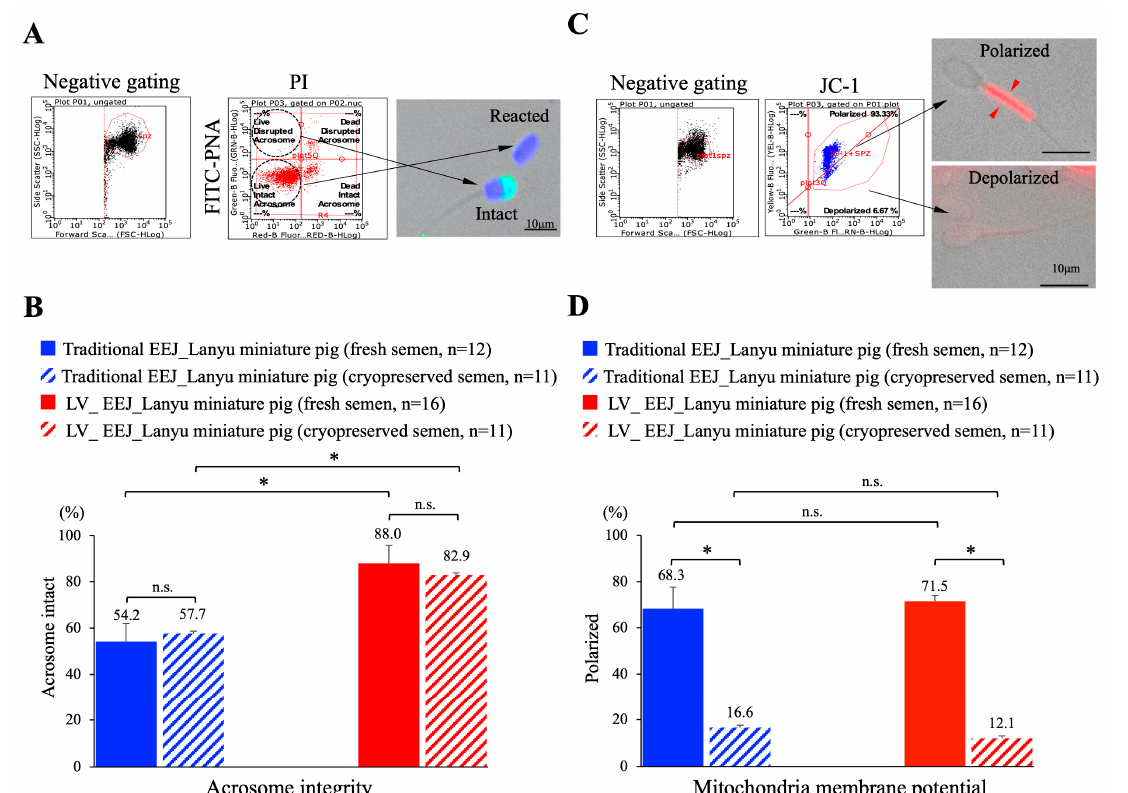
Figure 4. Sperm characterization (II). ( A ) Sperm acrosome integrity in live sperm was evaluated by co-staining FITC-PNA (for acrosome integrity) and propidium iodide (PI). Gating of sperm and non-sperm cells was first performed, and events counted in the second (live, acrosome disrupted) and the third (live, acrosome intact) quadrant were presented and compared. ( B ) Quantitative analysis of acrosome integrity in zoo captive lanyu mini pigs before and after cryopreservation showed significant di ff erence regarding acrosome integrity between traditional and low-voltage EEJ indicated low-voltage EEJ caused less damages on acrosome structure. ( C ) Sperm mitochondria membrane potential was evaluated by JC-1 stain. Gating of sperm and non-sperm cells was first performed and illustration of polarized (healthy) and depolarized (unhealthy) sperm were shown. ( D ) Quantitative analysis regarding mitochondria membrane potential showed no di ff erences between two stimulation protocols (between solid closed bars), indicated low-voltage EEJ did not compromise mitochondria function as compared with traditional EEJ. Significant declined in percentage of sperm cells with polarized mitochondria membrane potential was detected after cryopreservation in both protocols. Statistical di ff erence was set at p < 0.05 and significance was marked with asterisks (*), n.s. = no significant. Data presented as mean ± standard deviation (SD). In total 10,000 events were counted in flow cytometry analysis.